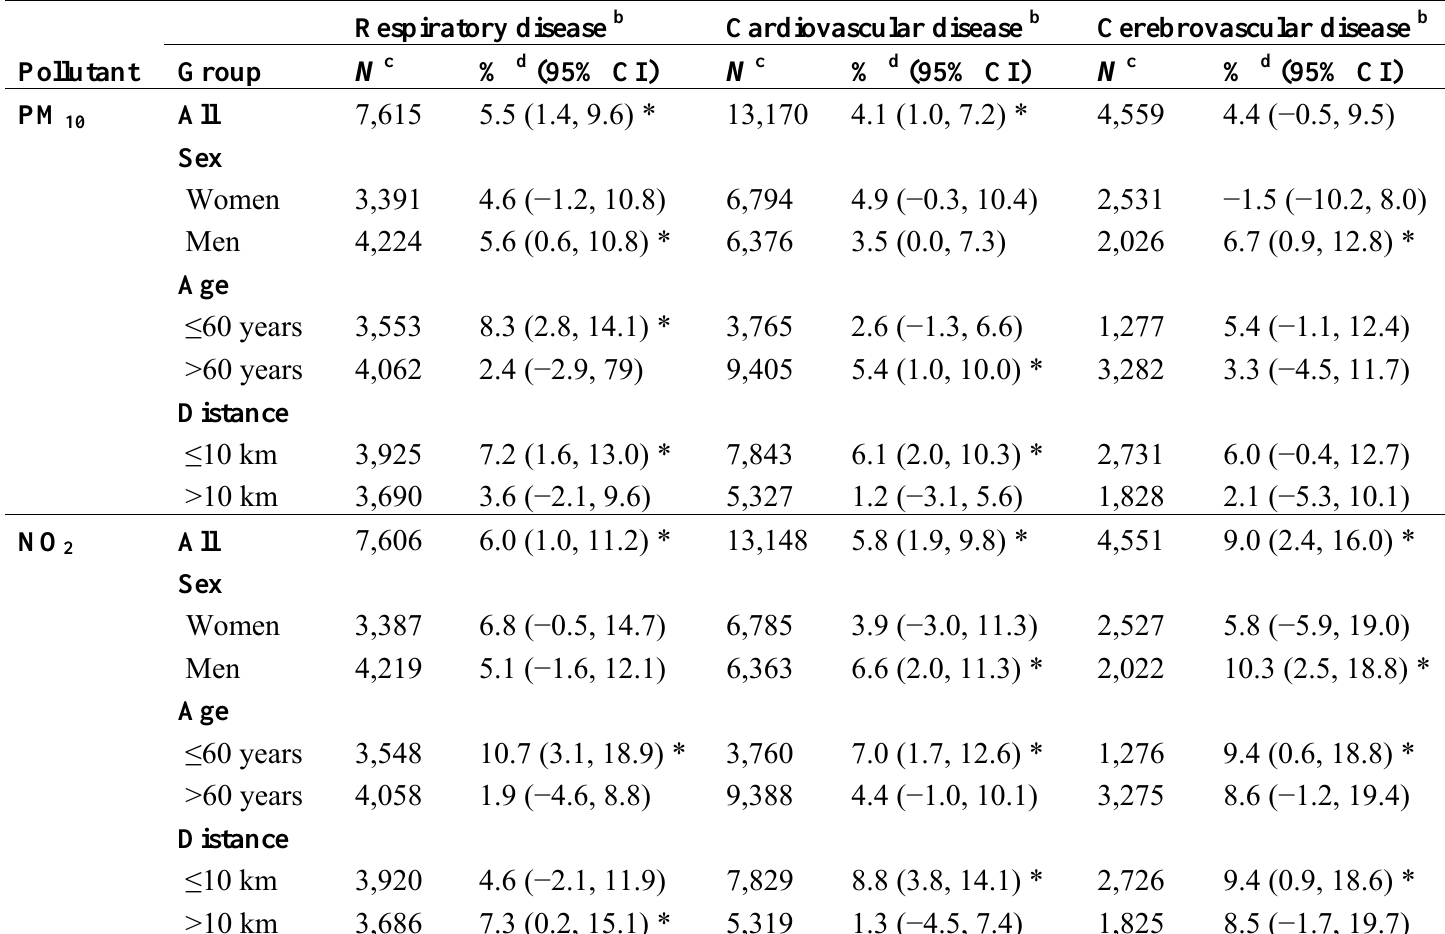
Table 3. Association between air pollutant and cause-specific mortality in Cape Town, South Africa (warm period a ,